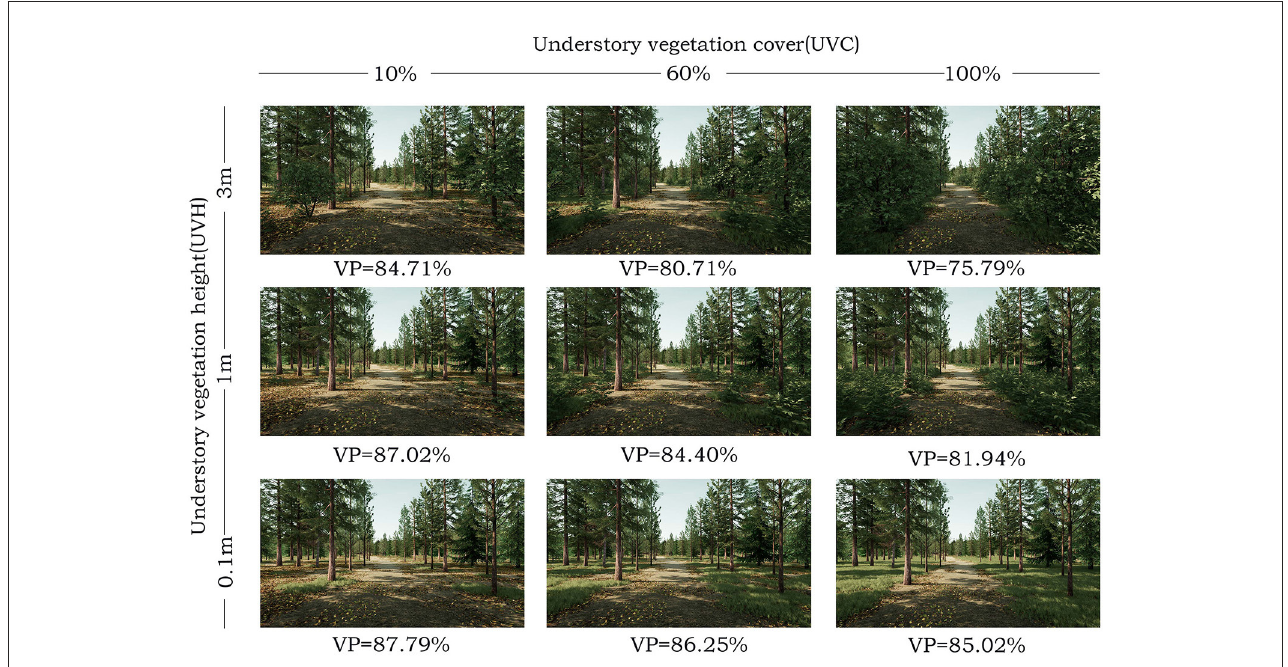
FIGURE1 Research stimulus of coniferous forest in the virtual reality video display. VP, vegetation permeability.